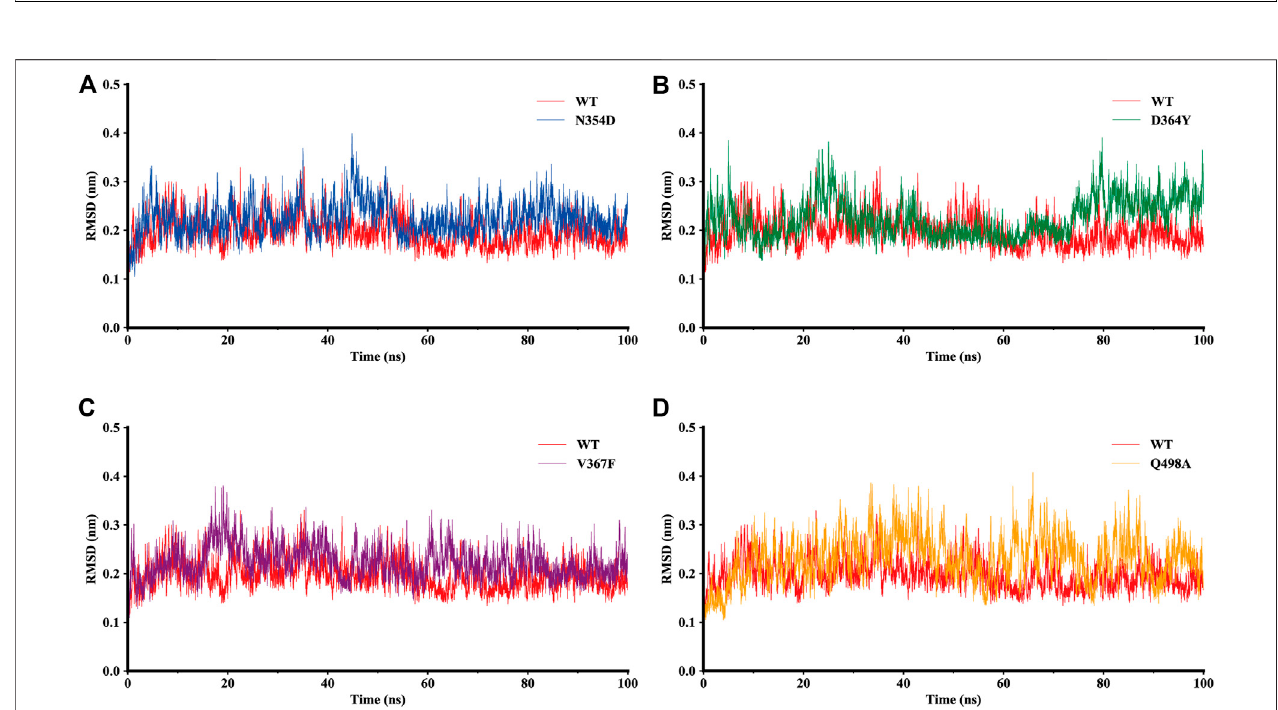
FIGURE2| RMSD ofbackboneatomsrelative totheinitialstructure during theMD trajectories. (A) RMSD valuesintheWT system(red) and N354Dsystem(blue). (B) WT system and D364Y system (green). (C) WT system and V367F system (purple). (D) WT system and Q498A system (orange).